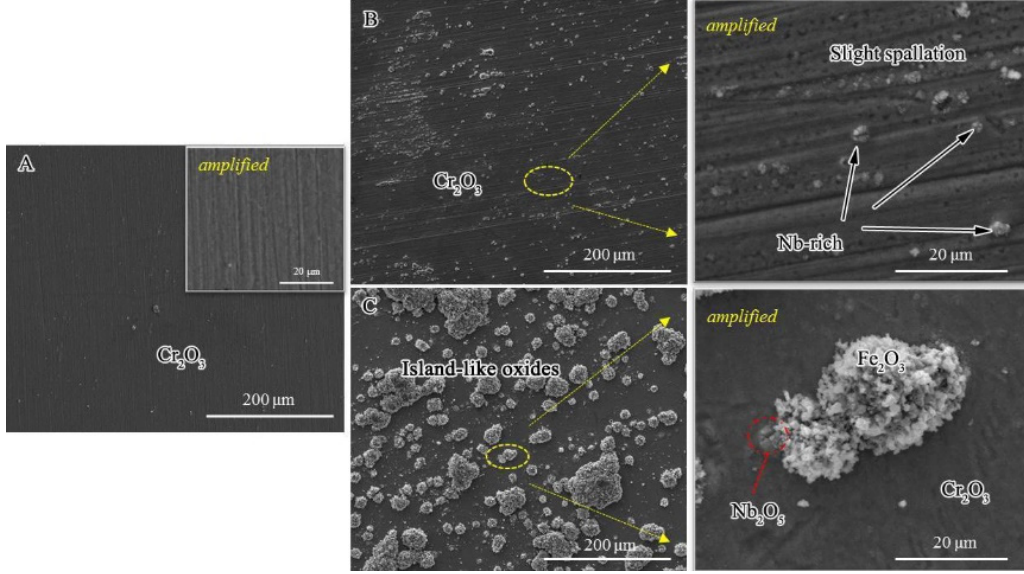
Figure 4. Surface morphologies of the alloys after oxidation in pure water vapor at 650 °C for 1000 h: ( A ) commercial HR3C alloy, ( B ) 1#HR3C alloy, and ( C ) 2#HR3C alloy.